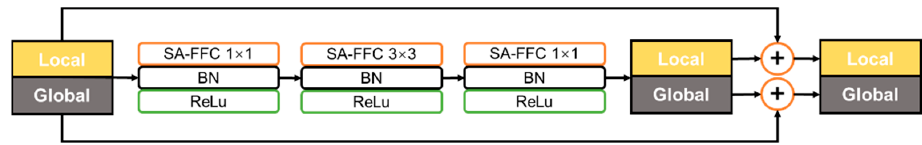
Figure 7. The basic block of FFC-SA ResNet.